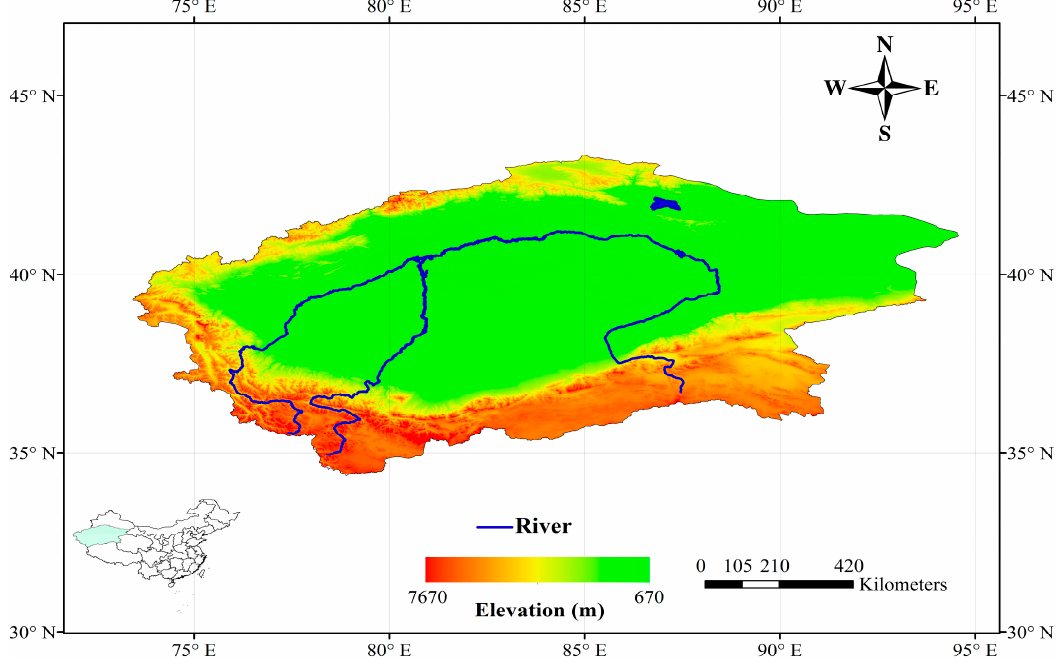
Figure 1. The schematic topography map of the study area.